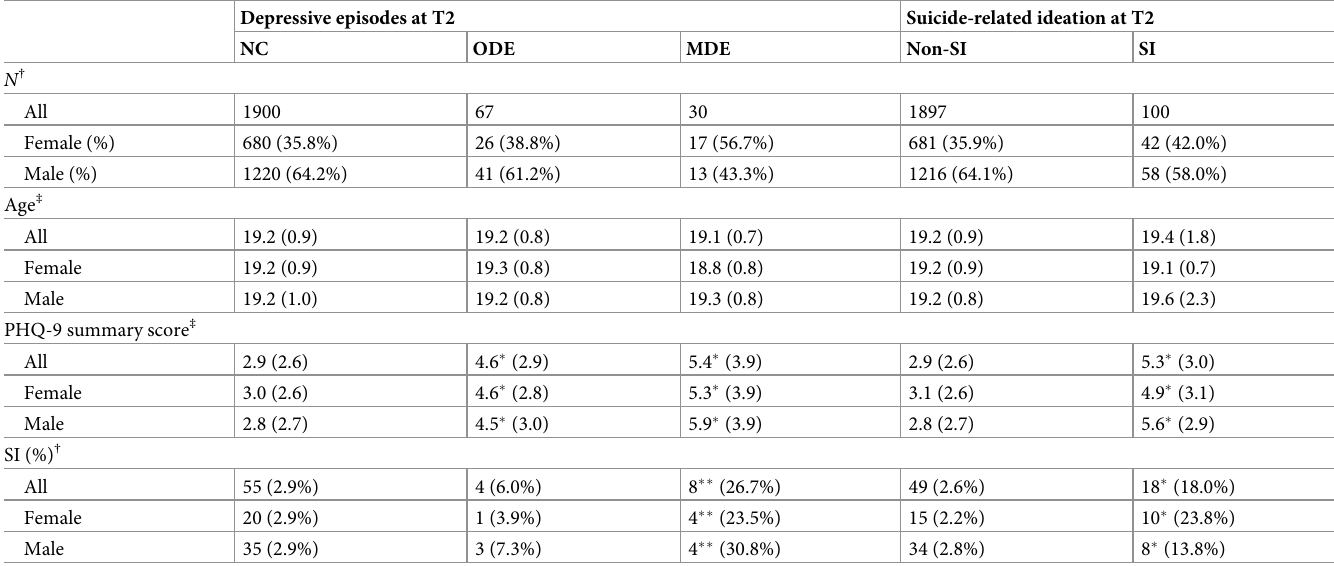
Table 1. Baseline data.